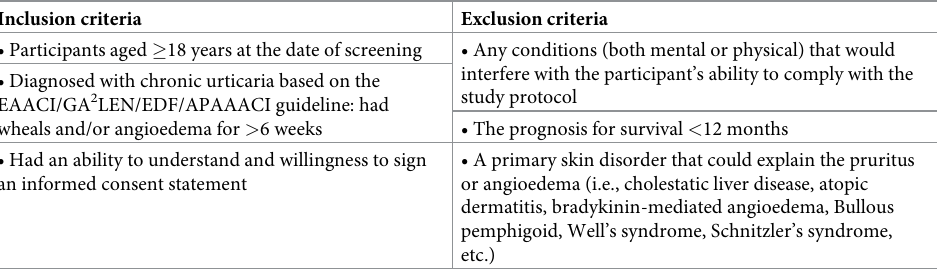
Table 2. Eligibility criteria of the CORE-CU